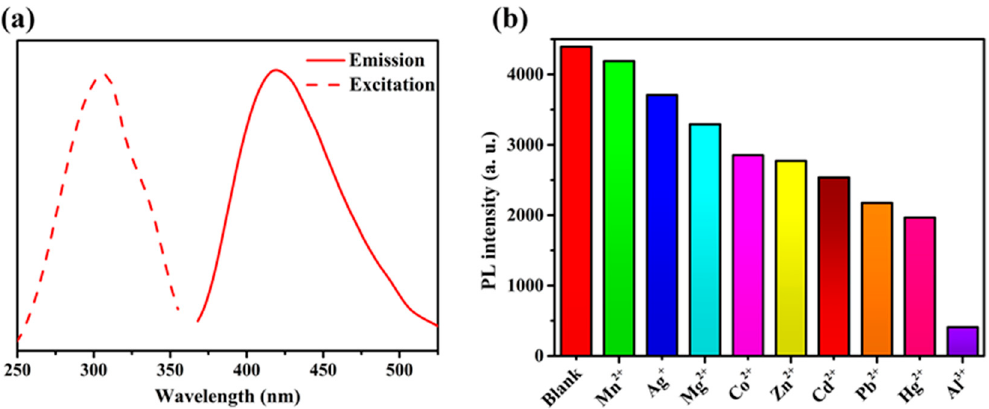
Figure 7. ( a ) Fluorescence spectra of the ligand in ethanol. ( b ) Luminescence intensities of 2 in different metal cations.